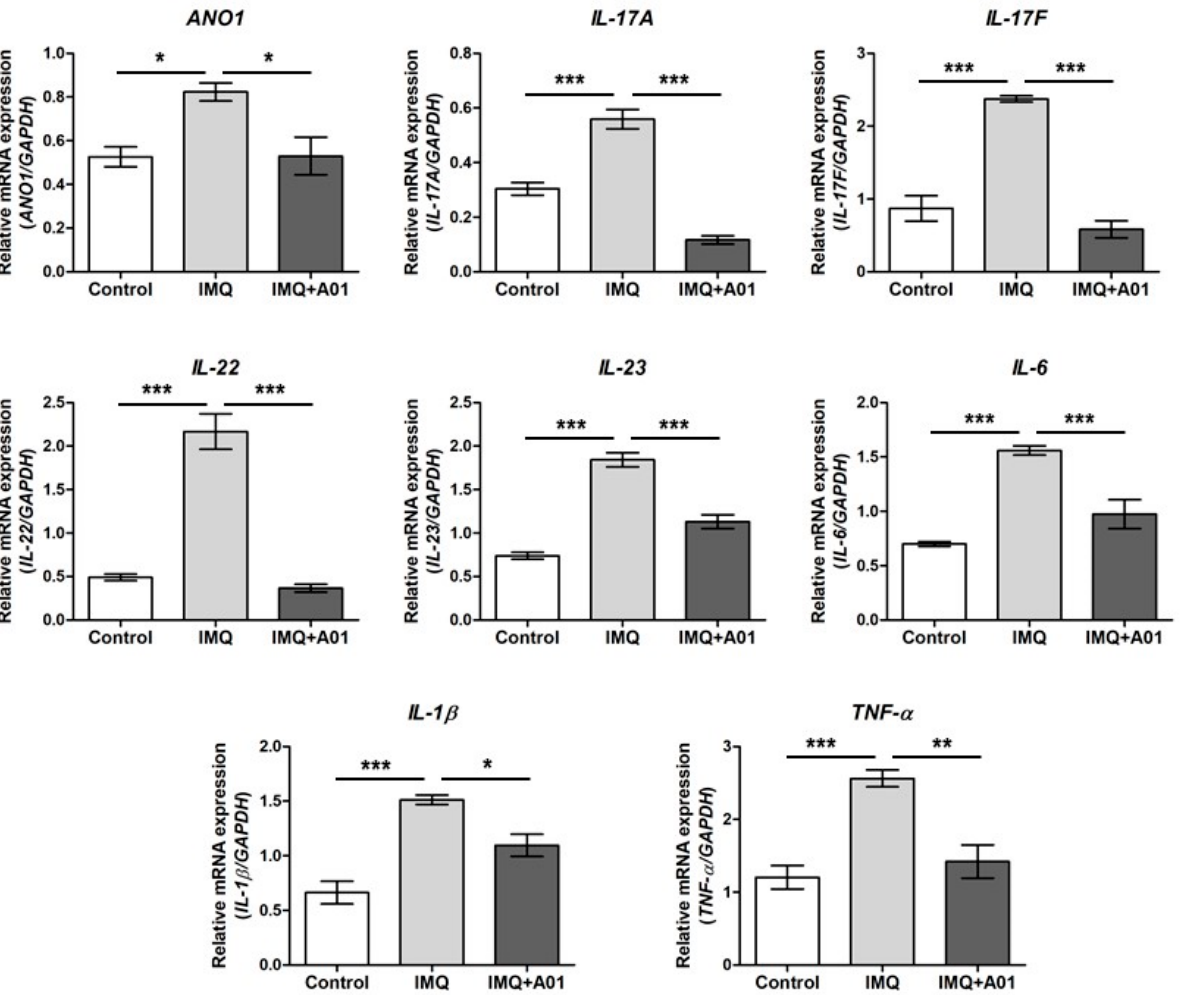
Figure 6. Changes in ANO1 and immune response-related cytokine mRNA levels in mouse ears showing psoriasis-like symptoms caused by inhibiting ANO1. Two mouse groups (IMQ [ n = 7] and IMQ + A01 [ n = 7]) received a daily dose of 25 mg of 5% IMQ cream on right ears for 7 consecutive days, and the IMQ + A01 group additionally received 15 µL of 100 µM A01 at 30 min before and after IMQ treatment. The control group received a similar dose of Vaseline cream on their right ears. After extracting total RNA from the right ears of the mice (7 animals in each group), obtained on the eighth-day post-treatment onset, target genes were analyzed using RT-PCR.; their expression levels were measured and represented as densitometric graphs. To compare the differences among groups, one-way ANOVA and Tukey’s post-hoc tests were used. *: significantly different between two groups (* p < 0.05, ** p < 0.01, and *** p < 0.001). Imiquimod, IMQ; T16Ainh-A01, A01.